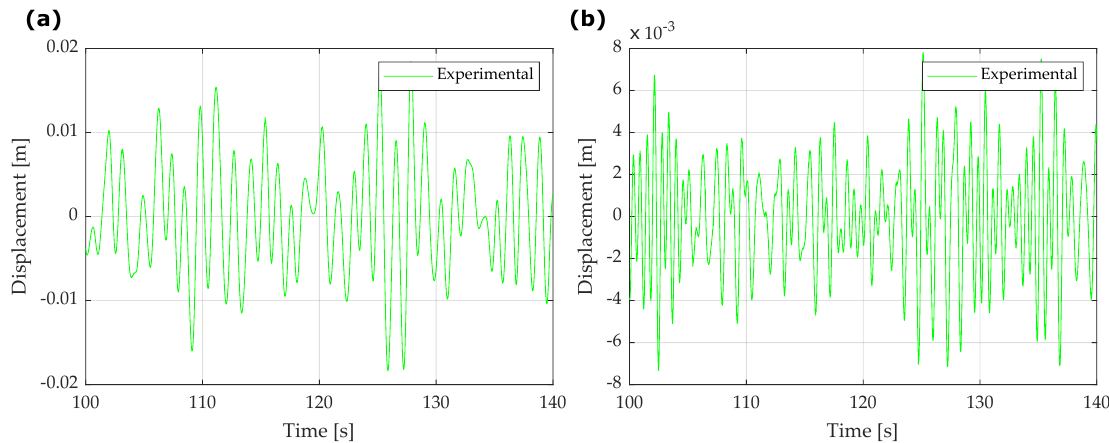
Figure 7. ( a ) Experimental time series data of the surge displacement of the TLP, when exposed to waves generated from a scaled down JONSWAP wave spectrum. ( b ) Experimental time series data of the surge displacement of the tower top, when exposed to waves generated from a scaled down JONSWAP wave